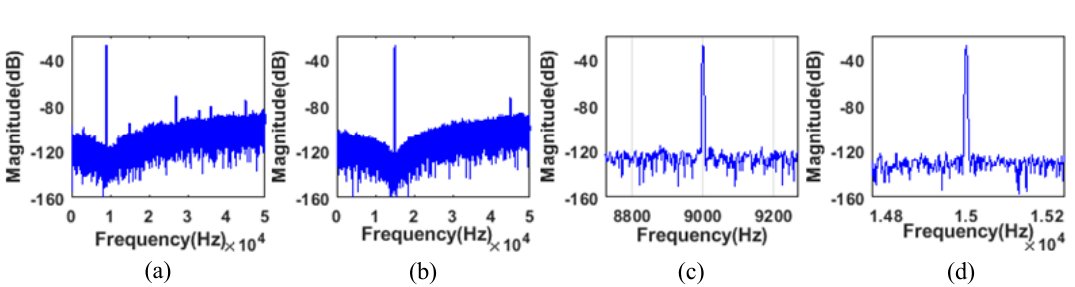
Figure 14. Spectrums of the output signal of the second-order ΣΔ modulator with signal observation. ( a ) A 9 kHz input sinusoidal wave and ( b ) a 15 kHz input sinusoidal wave. ( c ) Partial view of the spectrum in ( a ) near 9 kHz. ( d ) Partial view of the spectrum in ( b ) near 15 kHz.